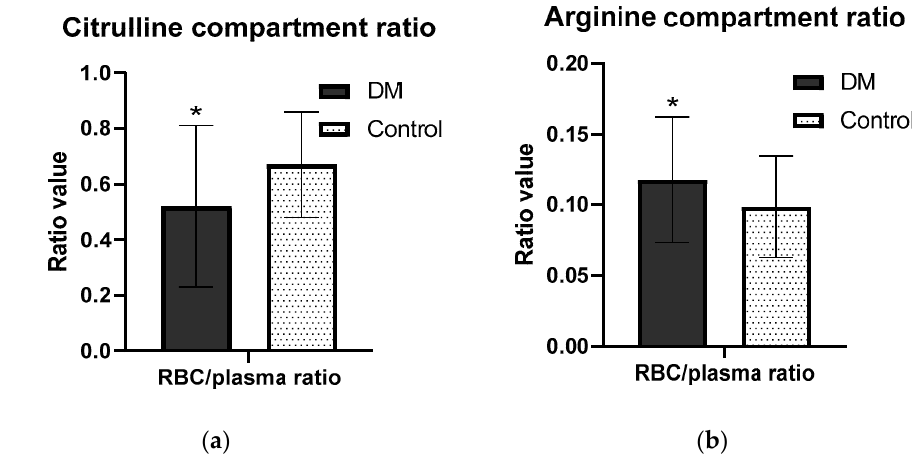
Figure 3. ( a , b ) Citrulline and Arginine compartment ratios. *- p < 0.05 vs. control .